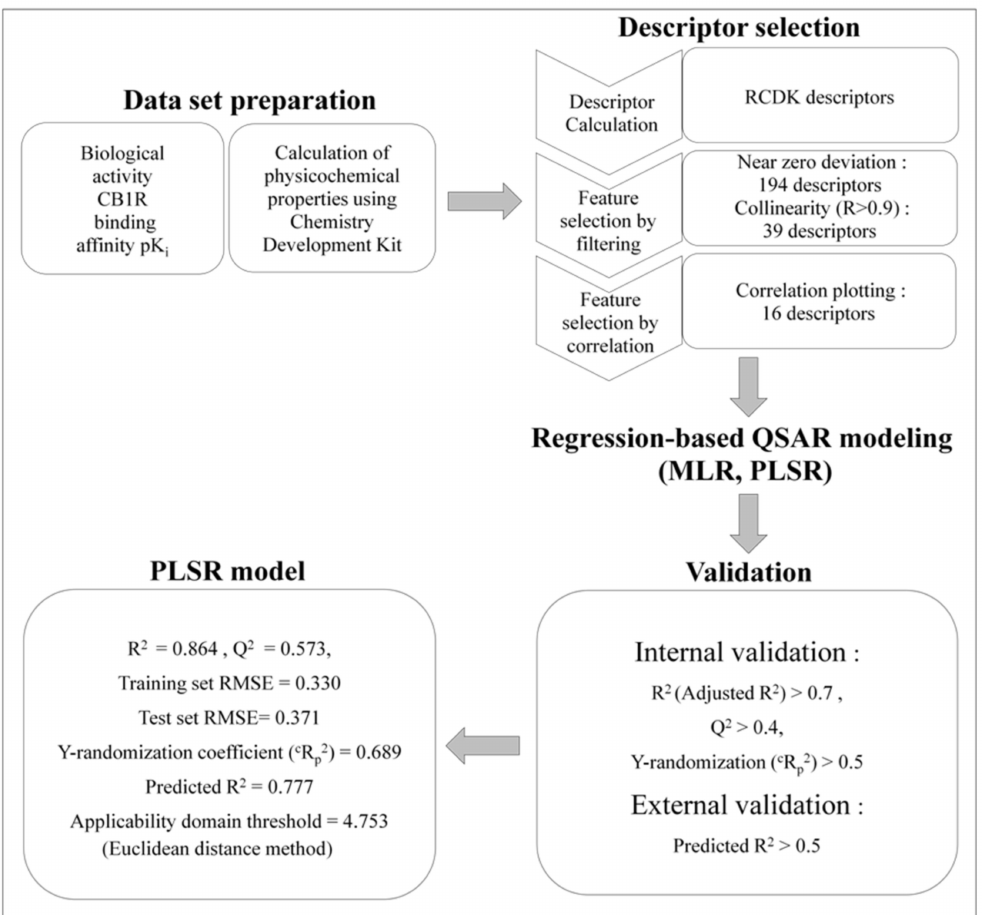
Figure 2. Quantitative structure–activity relationship modeling